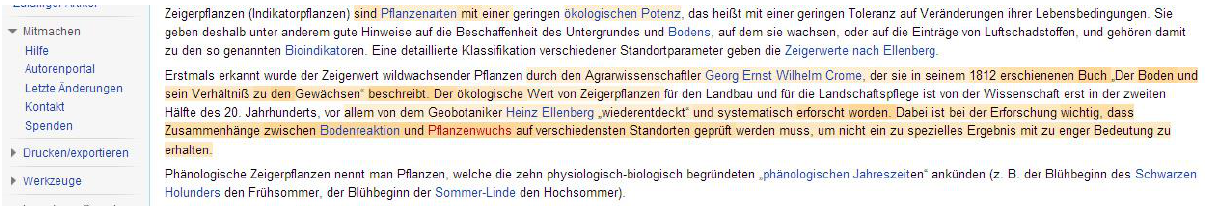
Figure 1. Representing the credibility of content to users by WikiTrust through different text and text background colors (Source: http://en.wikipedia.org/wiki/WikiTrust)